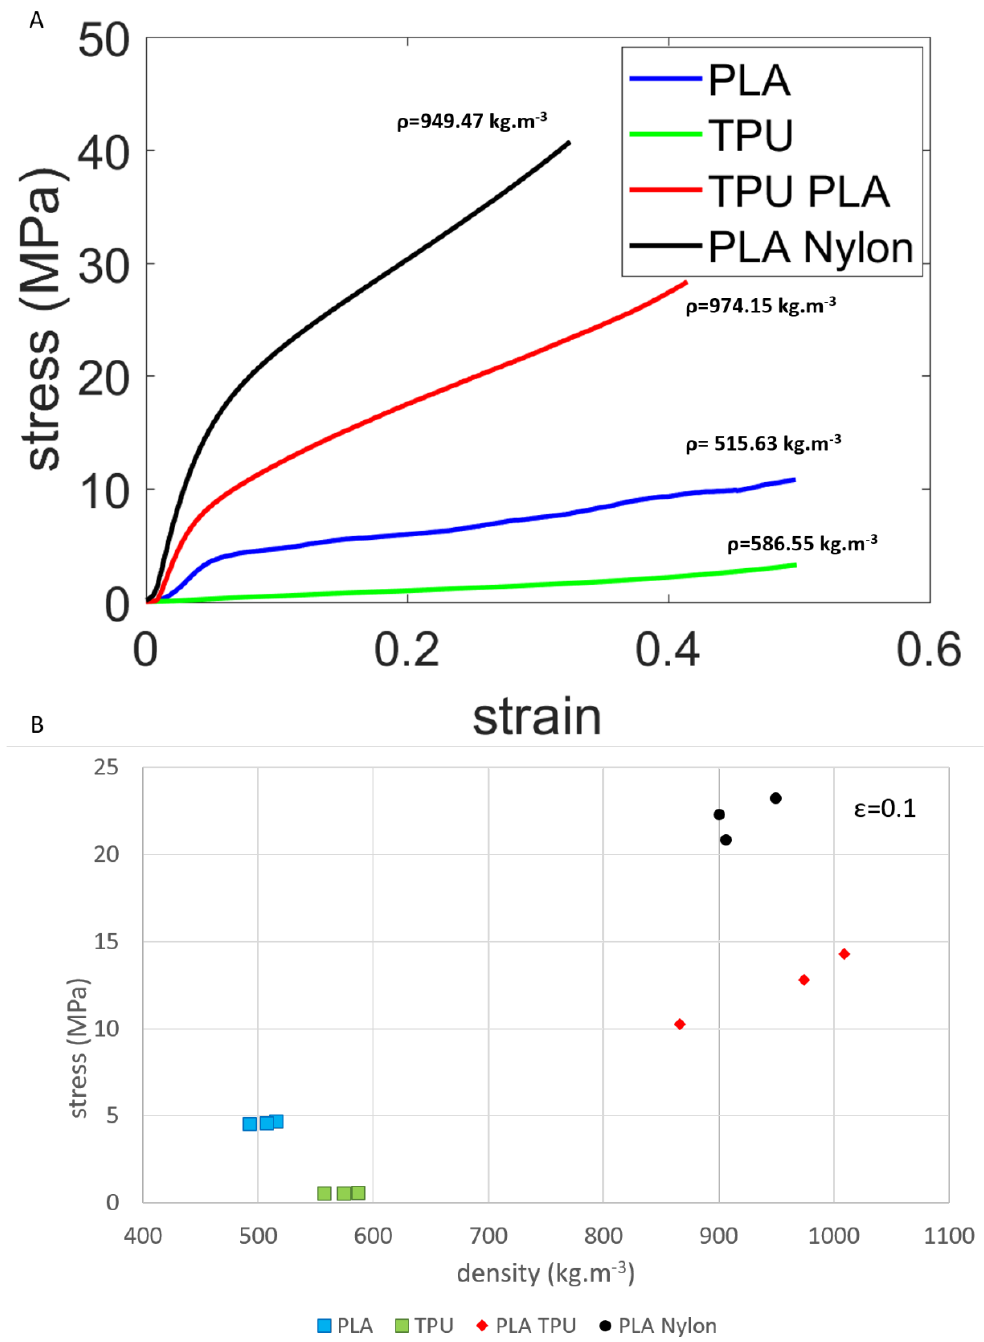
Figure 5. ( A ) Nominal stress and strain compressive response of porous PLA, porous TPU, PLA and TPU composite, PLA and Nylon composite. ( B ) Stress at 0.1 strain and density for the tested specimens.